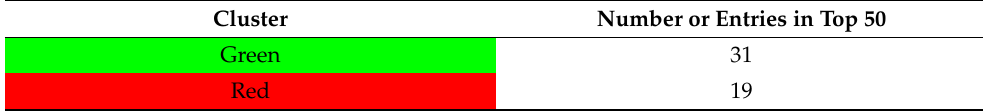
Table 9. Overview cluster distribution of top 50 keywords according to relevance. Cluster